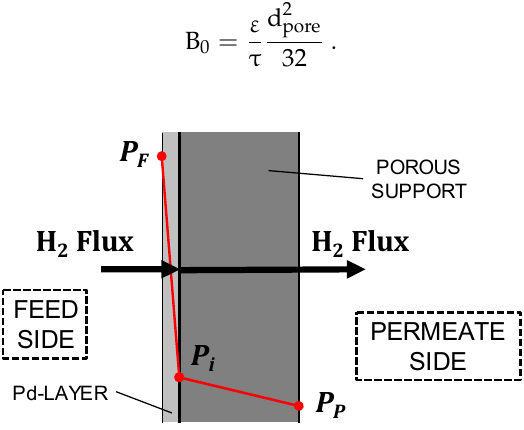
Figure 2. Model of the Pd composite membrane [22].